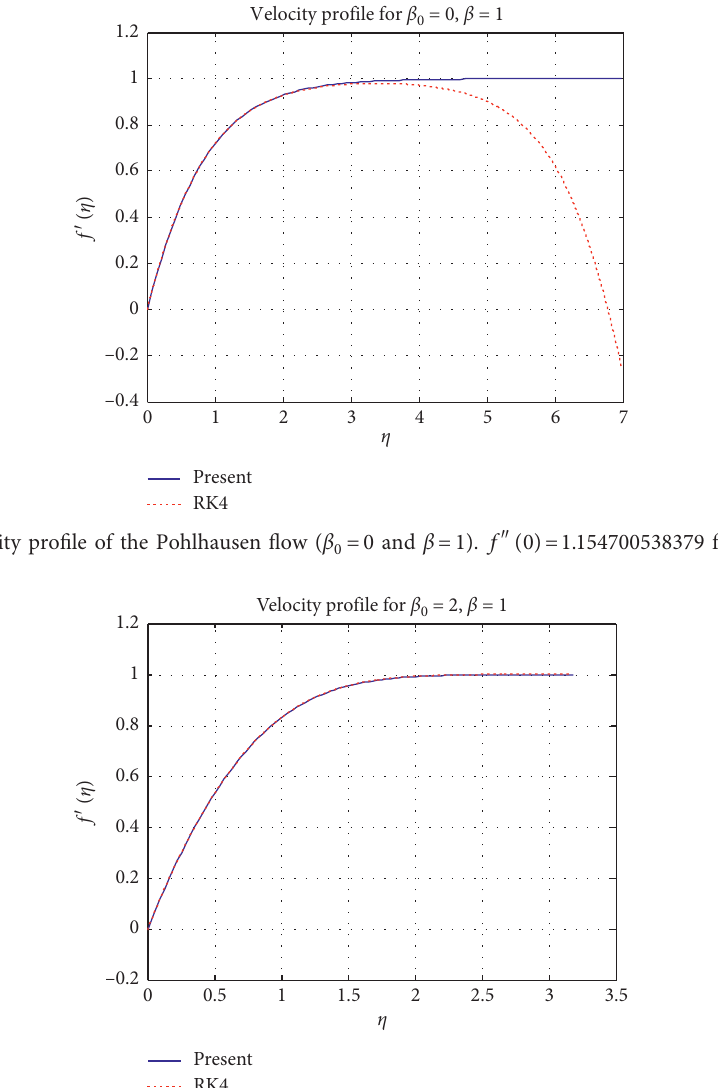
Figure 6: Velocity profile of the problem of Homann, describing steady flow in the boundary layer along a surface of revolution near the � 2 and β � 1). f ″ ( 0 ) � 1.311937693752 for L � 3.18407676. stagnation point ( β 0